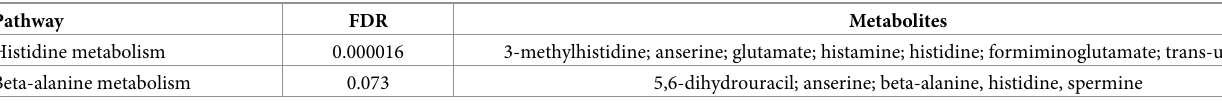
Table 2. Results of pathway enrichment analysis for wooden breast metabolites. Pathway